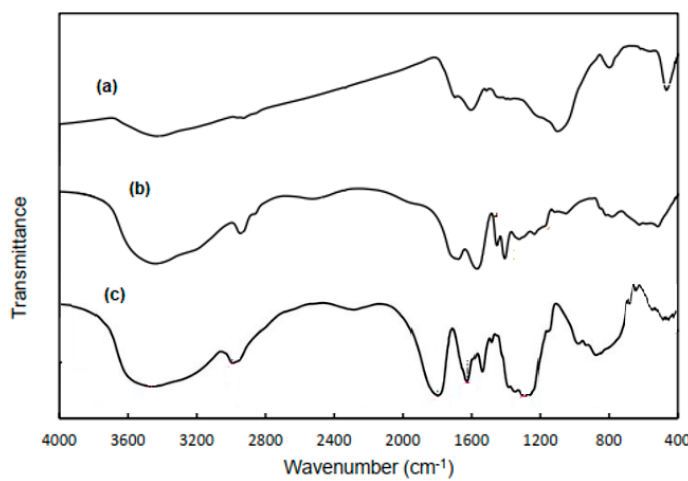
Figure 2. FTIR spectra of (a) biochar, (b) CMC-g-(TerPolys)/biochar composite, (c)